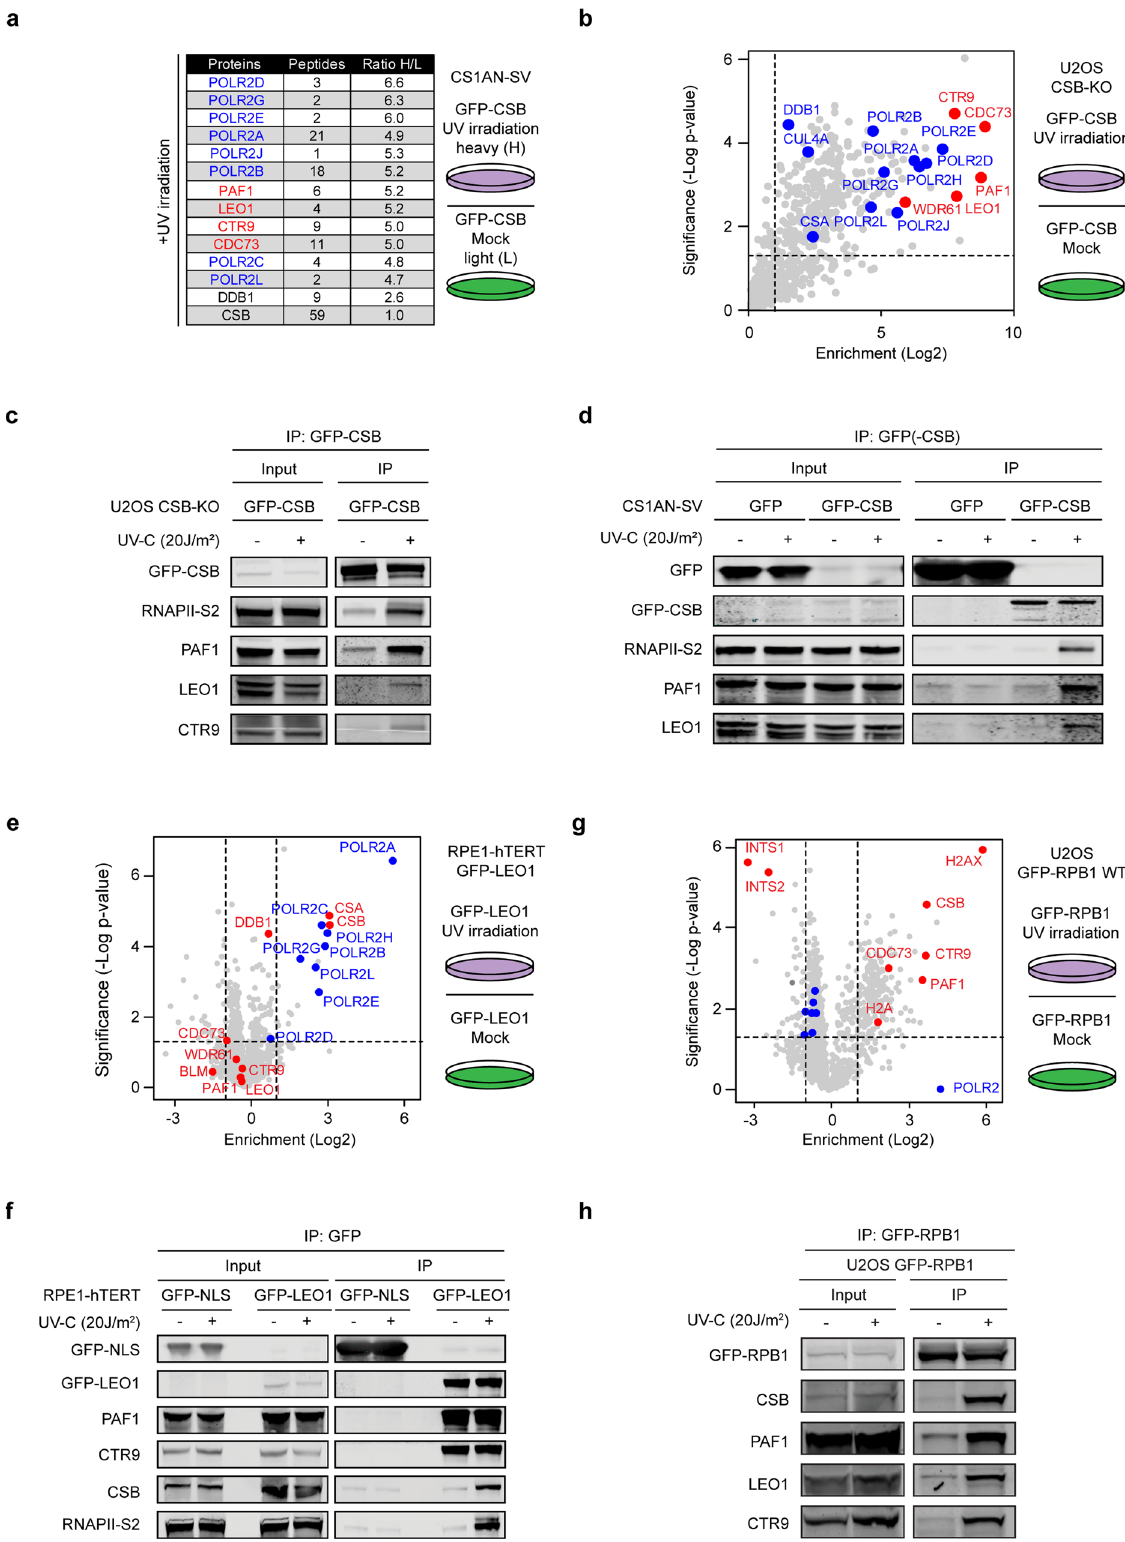
Ser5-P or a Ser2-P-speci fi c antibody con fi rmed these interactions (Supplementary Fig. 1k). The UV-induced interaction between PAF1C and RNAPII is mediated by CSB . The association of PAF1C with RNAPII